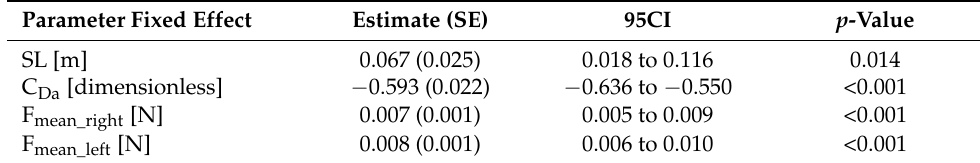
Table 3. Fixed effects of the final model including standard errors and (SE) and 95% confidence intervals